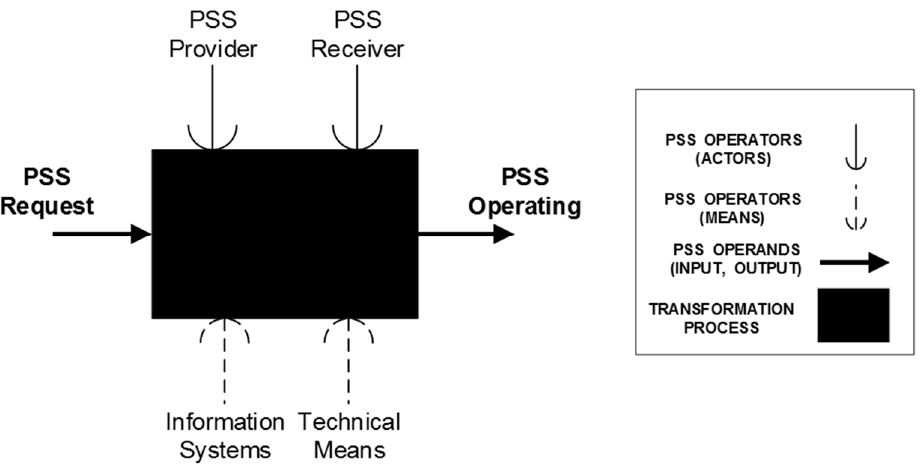
Figure 1. The PSS Black Box.